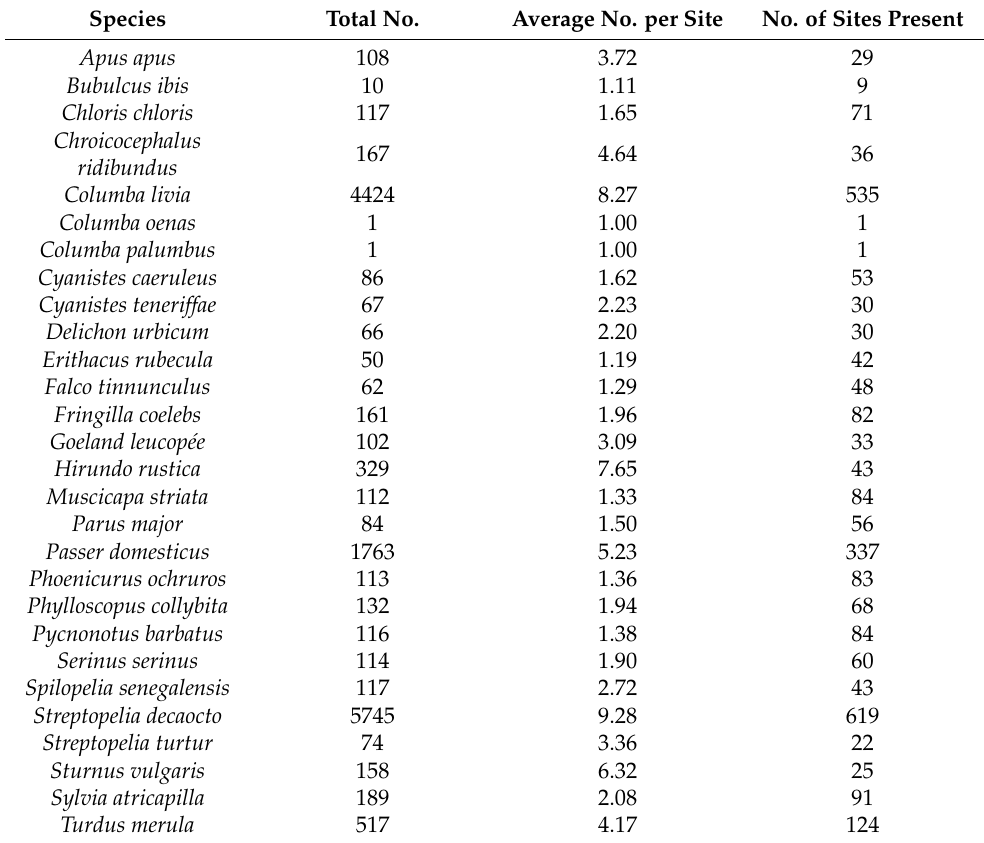
Table 1. Species found in Annaba, Algeria during 2017–2018. The table shows the total and average number per site and the number of sites where each species was